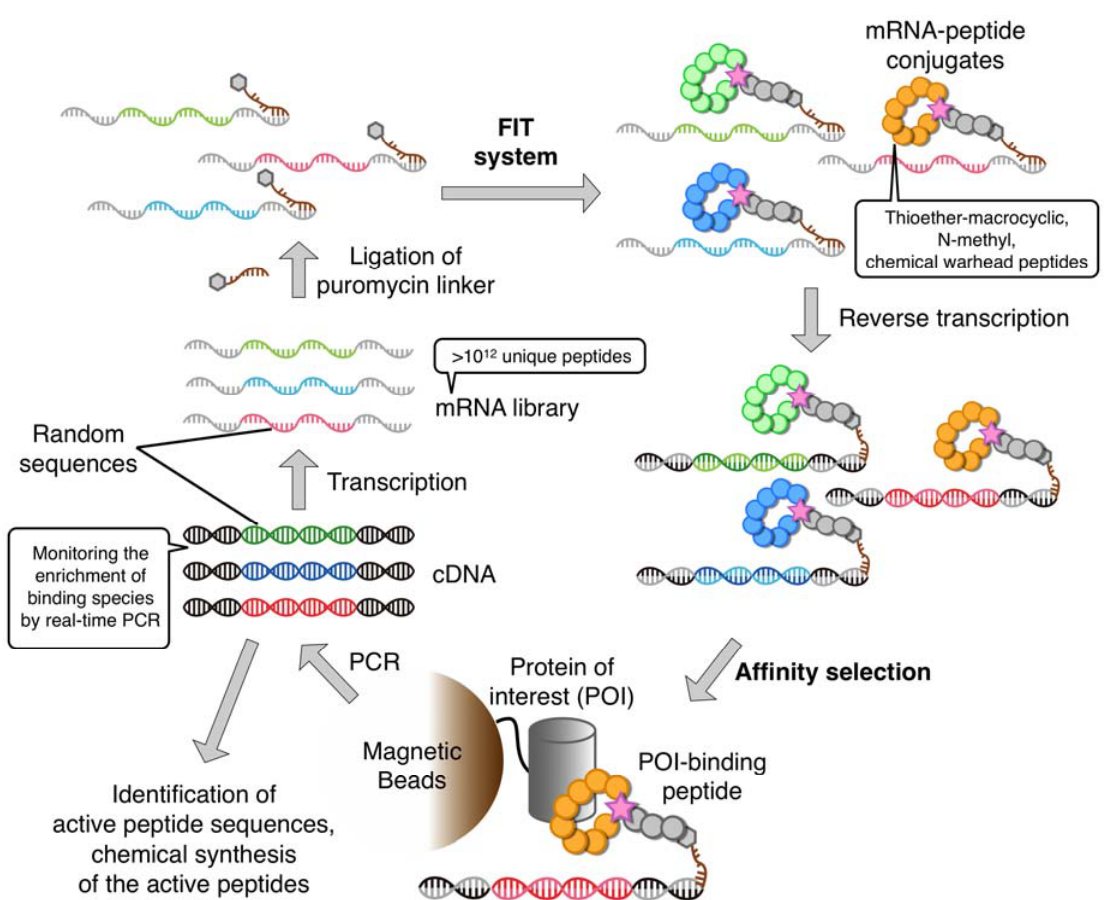
Figure 7. Schematic illustration of the RaPID system. First, a non-standard macrocyclic peptide library is ribosomally synthesized from an initial random mRNA library, each of which peptide is linked to its cognate cDNA by ligation of the mRNA to the peptide via a puromycin linker. After reverse transcription, peptides that potentially bind to the target protein are then isolated by an appropriate affinity-based selection procedure. cDNAs encoding the “hit” peptides are amplified and transcribed to generate the next, enriched,